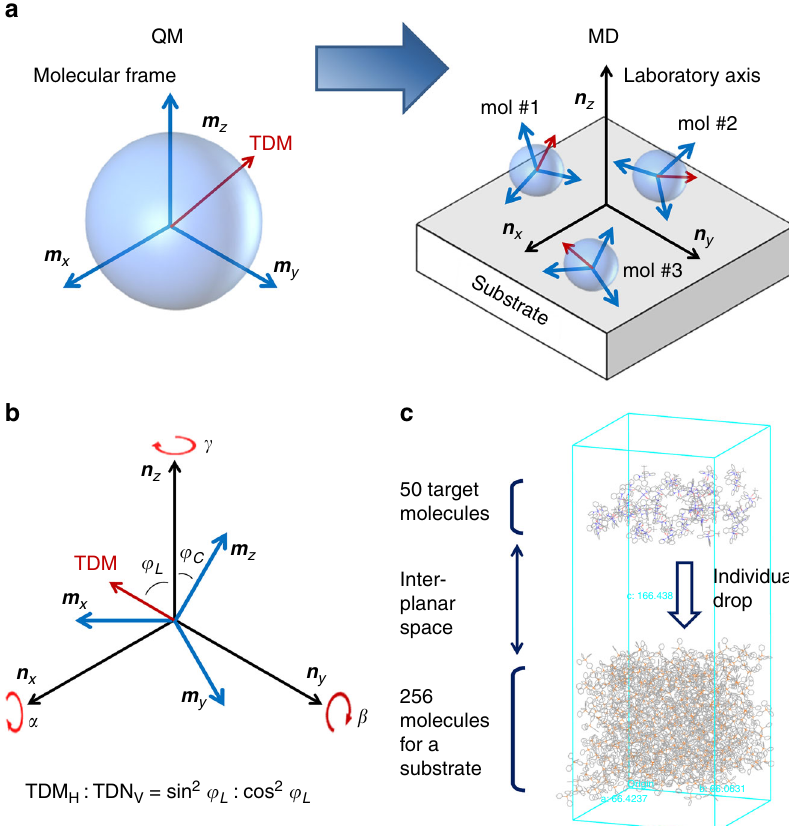
Fig. 1 Method for the simulation of the EDO of emitters in vacuum-deposited layers. a Transfer of the TDM vectors ( red arrow ) in the molecular coordinates to the vectors of the molecules on the organic substrate during the vacuum deposition simulation. b Three rotation angles ( α , β , and γ for the clockwise rotation to the n x -, n y -, and n z -axes, respectively) were the orientation parameters of the molecules to correlate the molecular orientation to the laboratory axis. Angles between n z axis and the TDM vector ( φ L ) and the C 2 axis ( φ C ) are obtained after the vector transformation. c A simulation box consisting of the substrate and target molecules. About 50 target molecules were located above the substrate with 5.0 nm of inter-planar space dropped individually at 300 K. The distance unit in the fi gure is angstrom